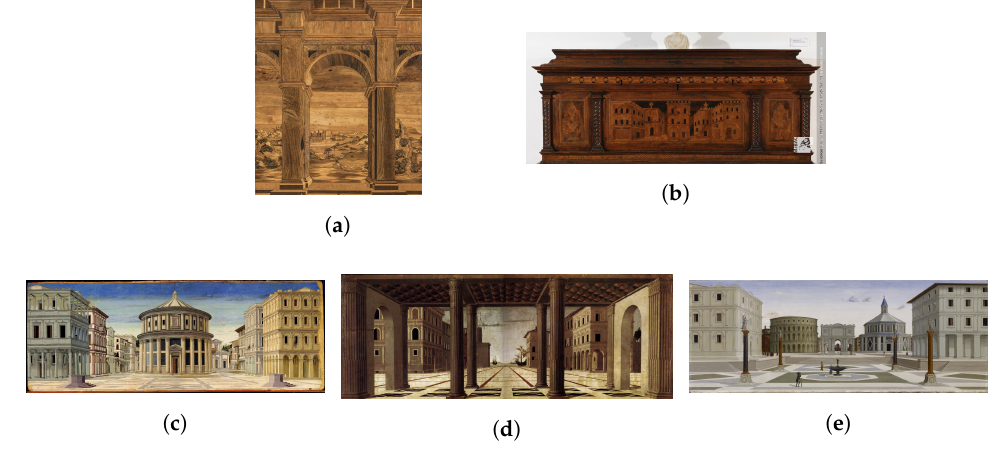
Figure 2. The paintings in our dataset. ( a ) depicts the Wooden panel in the “Studiolo del Duca” with Marche view. ( b ) represents the Inlaid chest in the National Gallery of Marche. ( c ) is the Ideal City in Urbino, ( d ) represents the Ideal City in Berlino, and ( e ) is a picture with the Ideal City in Baltimore.